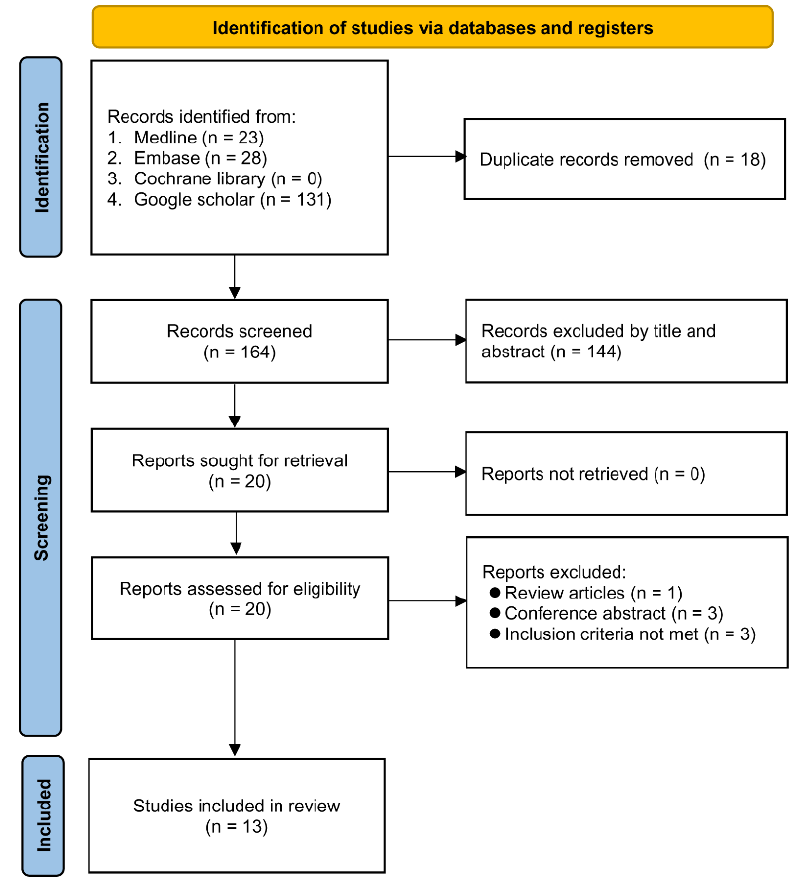
Figure 1. Flow chart for inclusion and exclusion.